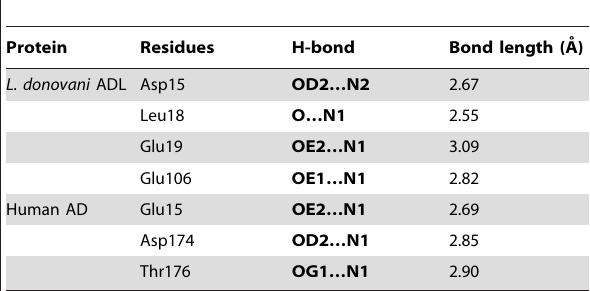
Table 3. Showing interaction of putrescine with residues in ADL and their comparison with interaction involved in putrescine binding in human AD.